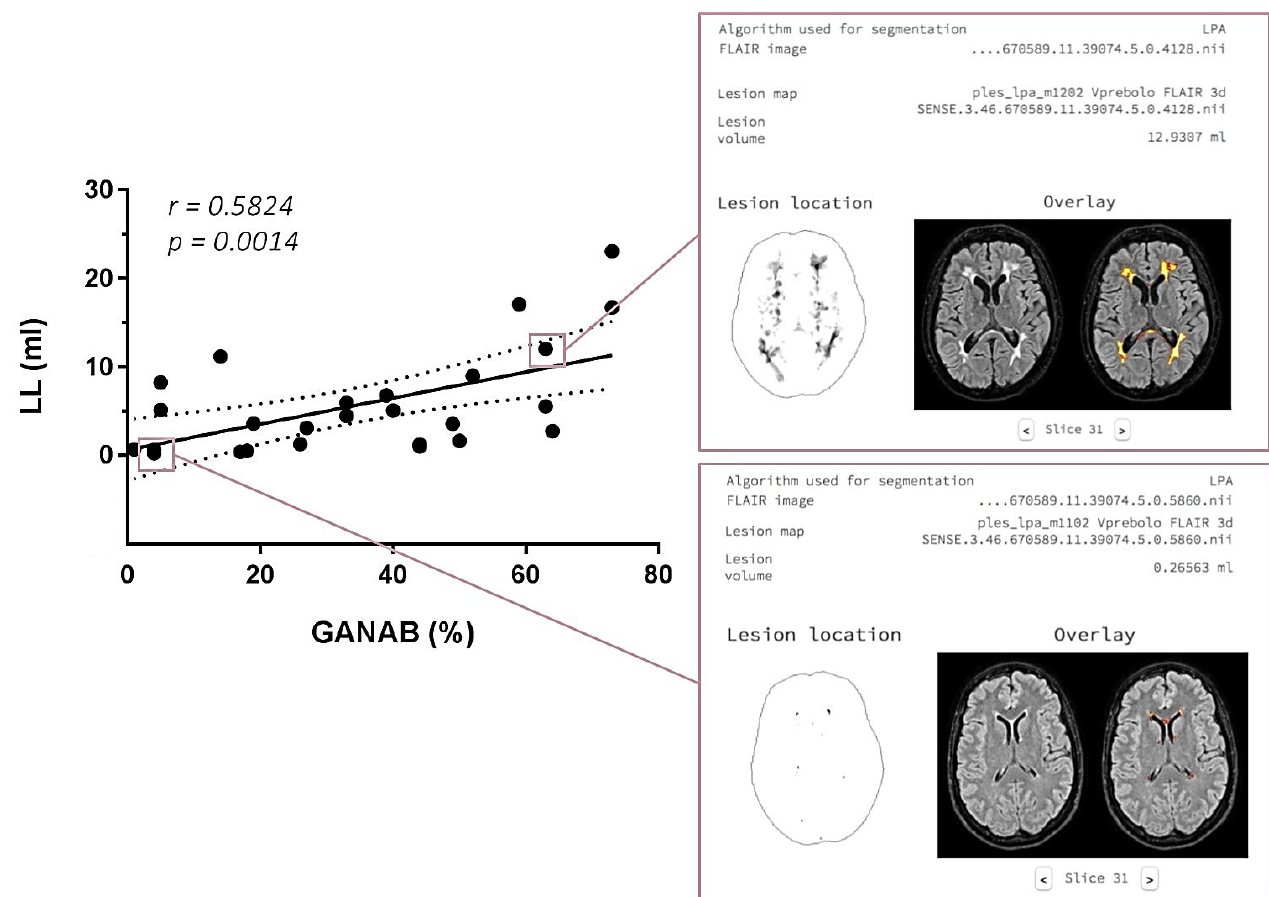
Figure 8. On the left: GANAB and LL correlation. Significant direct correlation between the quantitative expression of GANAB (%) and lesion load (LL) expressed in ml in the IFN-treated MS group. On the right: output image in the LPA report with segmented lesions on the 3DFLAIR image of two IFN-treated MS patients, one with a higher GANAB expression (63%) and lesion volume (12.9307 mL) (up) compared to the other with a lower GANAB expression (4%) and lesion volume (0.2656 mL) (down).